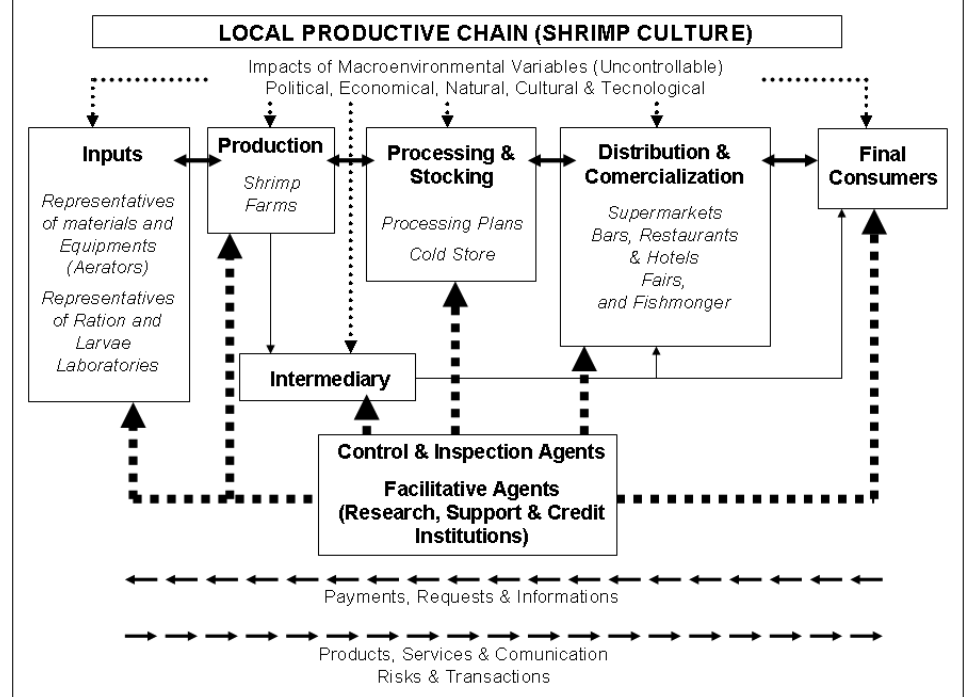
Fig. 2 – Local shrimp culture productive